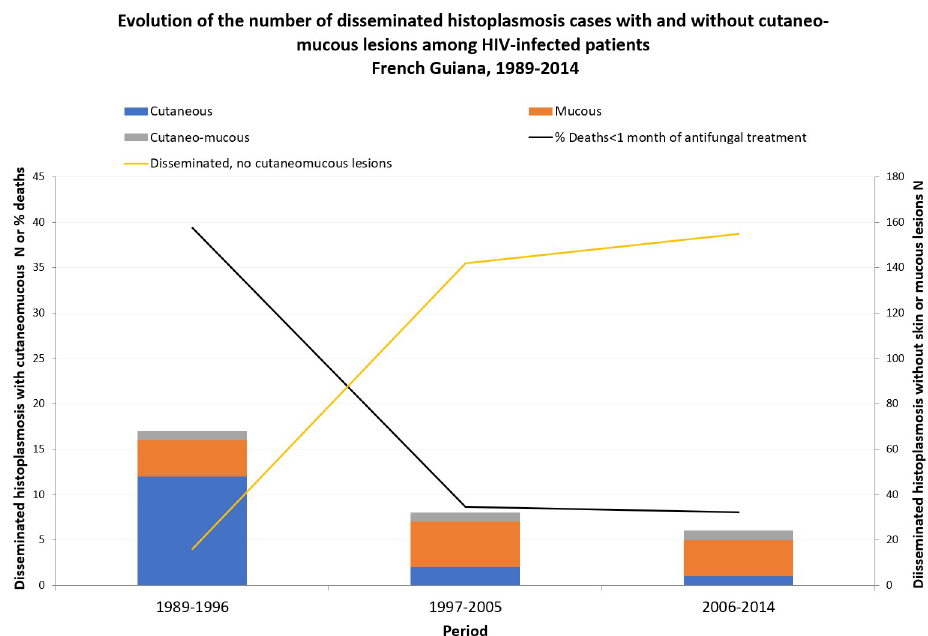
Fig 1. Evolution of the number of disseminated histoplasmosis cases with and without cutaneo-mucous lesions among HIV-infected patients, French Guiana, 1989–2014.